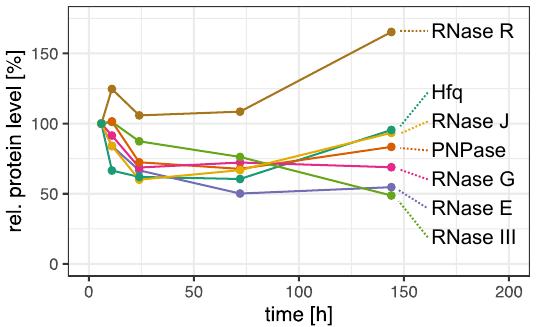
Figure 9. The levels of several RNases and of the RNA chaperon Hfq vary at different stages of growth as determined by quantitative mass spectrometry. R. sphaeroides wild type cultures were grown under microaerobic conditions and sampled in mid exponential phase (OD 660 = 0.5), in transition to stationary phase (11h after inoculation, OD 660 ≈ 1.0), in early stationary phase (24h after inoculation, OD 660 ≈ 1.8) and in late stationary phase (72and 144after inoculation, OD 660 ≈ 1.1) and a quantitative proteome analysis was performed as described in Bathke et al. [63]. Values for the RNases and for Hfq are taken from the data set of this